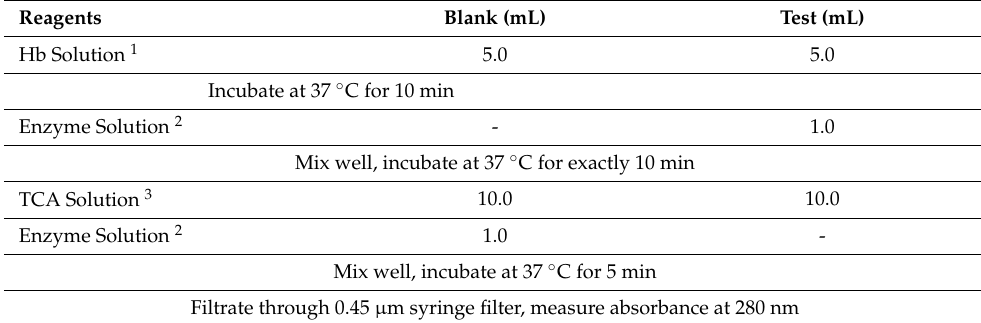
Table 1. Reagents and steps for Enzymatic Assay of